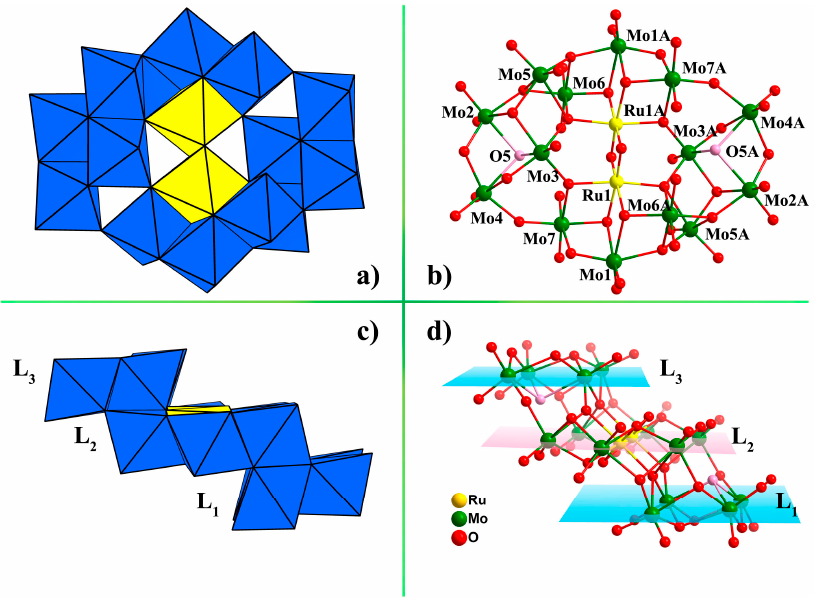
Figure 1. Top view of ( a ) polyhedral and ( b ) ball-and-stick representations of polyanion [ Mo VI14 Ru IV2 O 50 (OH) 2 ] 10 − ( 1a ); Side view of ( c ) polyhedral and ( d ) ball-and-stick representations of polyanion 1a . Color code: MoO 6 octahedral, blue; RuO 6 octahedral, yellow. The pink balls represent monoprotonated oxygen atoms.